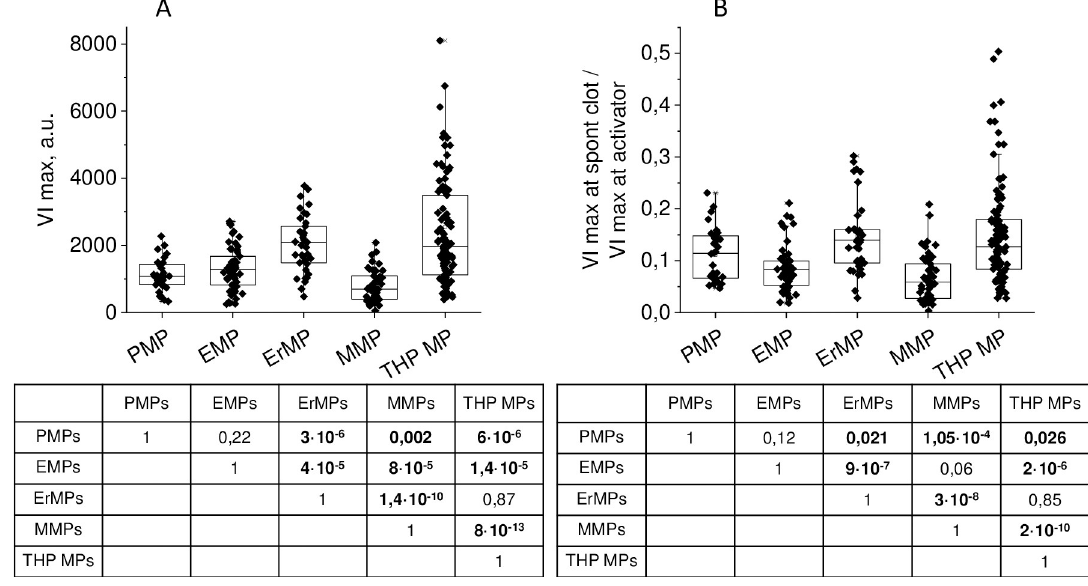
Fig 6. The maximal rate of increase of light scattering intensity in the centre of spontaneous clots and its ratio to the maximal rate of increase of light scattering intensity of clots growing from activator. (A) The mean maximal rate of light scattering intensity increase in the centre of spontaneous clots growth. (B) Ratio of the mean maximal rates of light scattering intensity increase in the centre of spontaneous clots growth to the maximal rate of light scattering intensity increase of clots growing from activator. Dots correspond to individual clots induced by different MP samples at different concentrations. Boxes on the plot bound the 25th and the 75th percentiles. Tables under histograms contain significance levels of corresponding parameter differences between MP of different origin according to Mann–Whitney